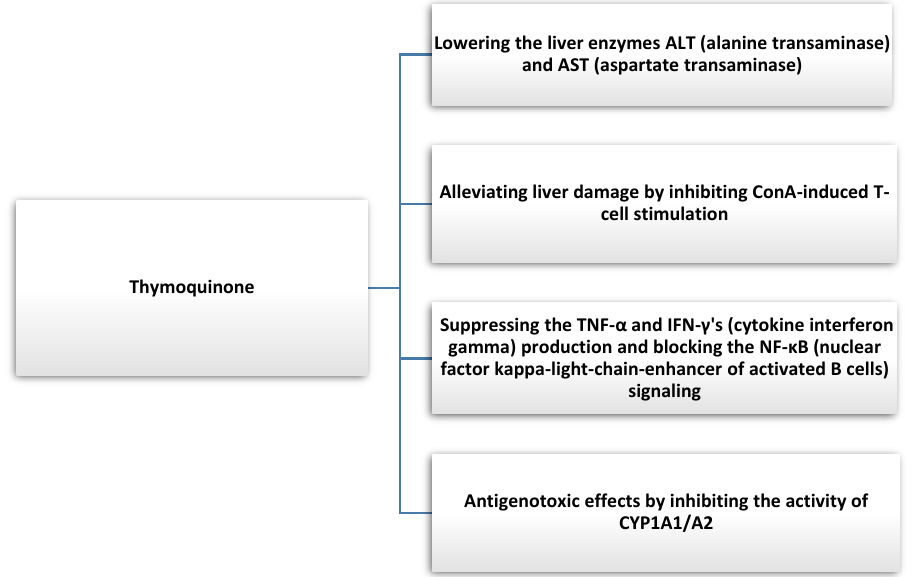
Figure 4. Hepatoprotective effect of thymoquinone found in Nigella Sativa